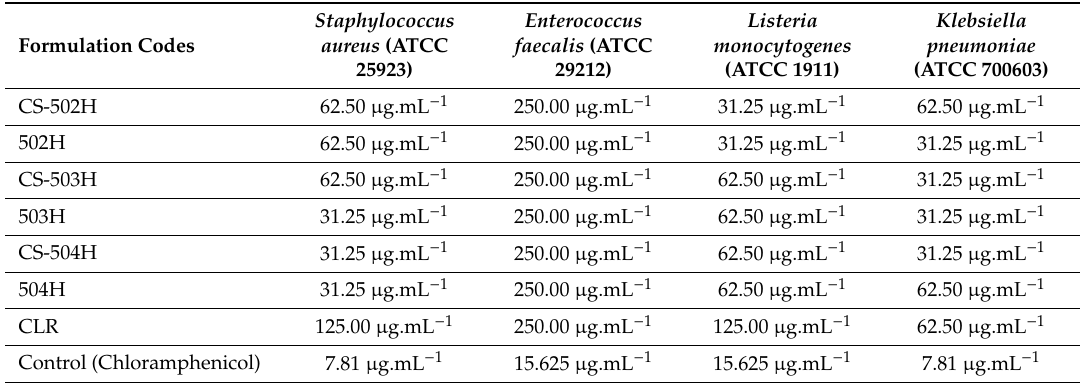
Table 8. Antimicrobial test